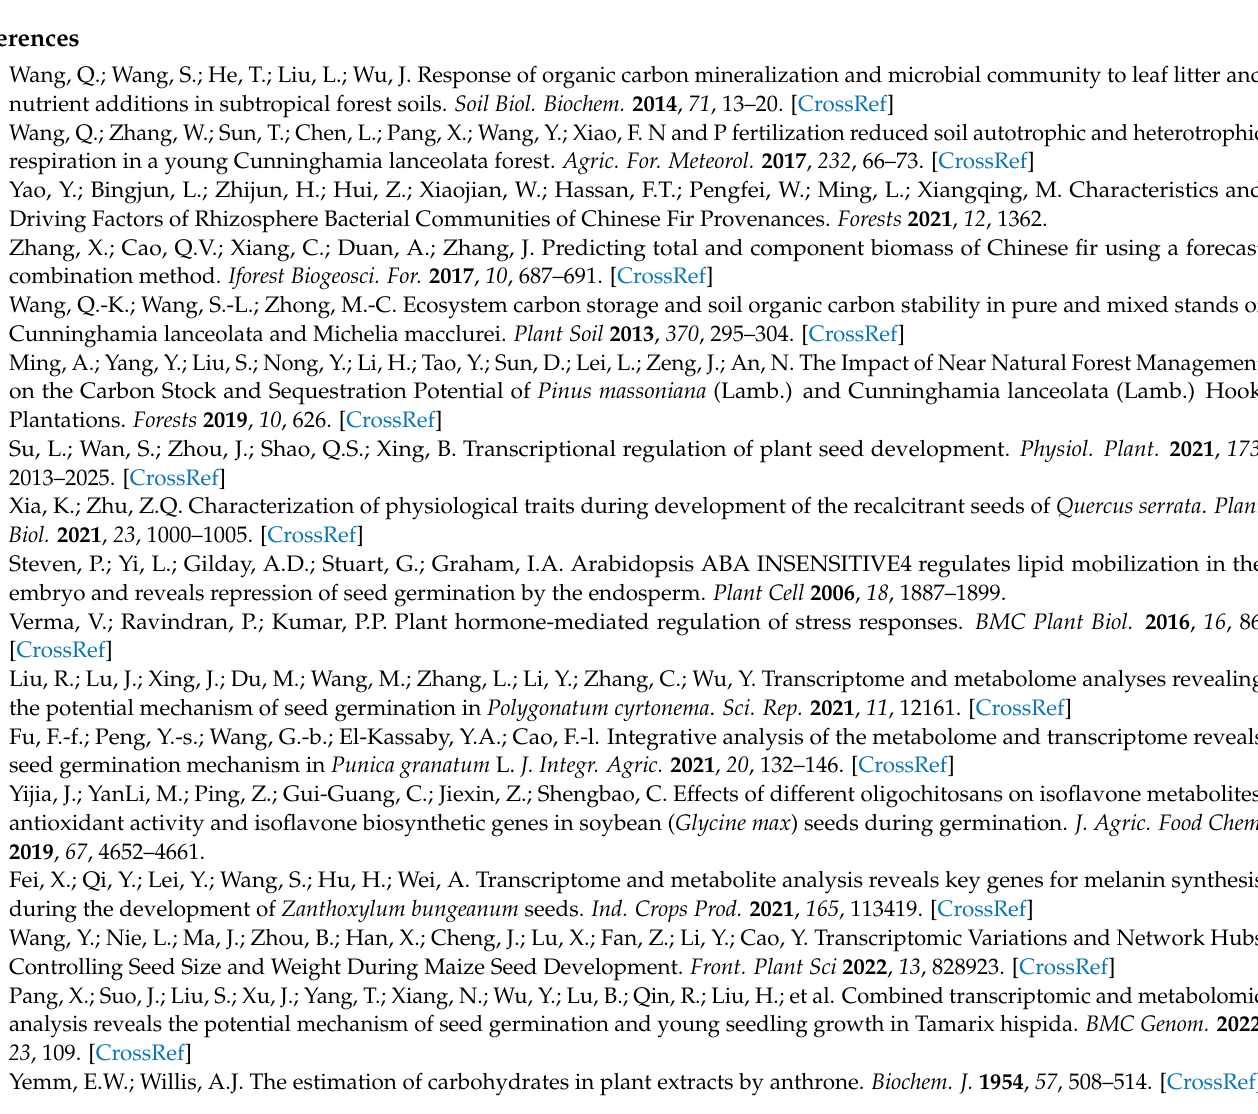
Figure S5 is a qRT-PCR validation of six genes. Table S1 shows the statistics of RNA-seq sequencing data for 12 samples; Table S2 shows the primer sequences for the six genes and the internal refer- ence genes; Table S3 shows the differentially expressed genes in the three comparison groups, and Tables S4 and S5 show the differential accumulation of metabolites for the three comparison groups in positive ion mode and negative ion mode,